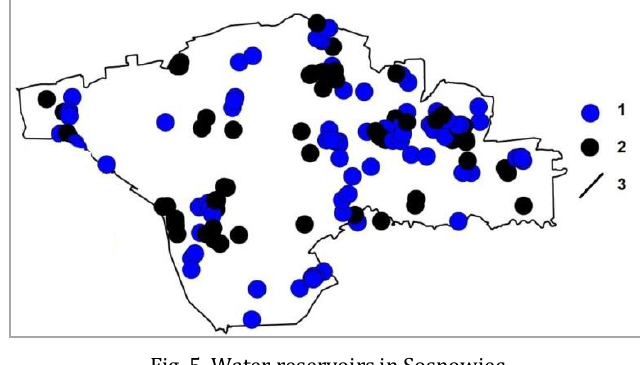
Fig. 5. Water reservoirs in